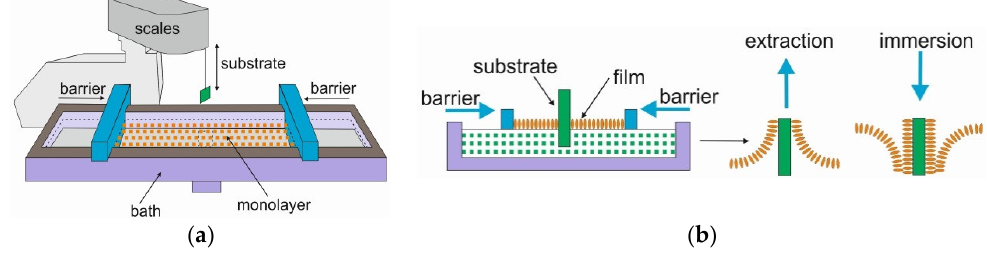
Figure 1. Langmuir–Blodgett deposition technique: ( a ) the setup, ( b ) the method idea. Thin (60 nm) layers of TiO 2 were obtained by a transfer from the liquid–solid interface to the solid substrates by consecutive immersion and extraction, as shown in Figure 1b. All experiments were performed at room temperature.